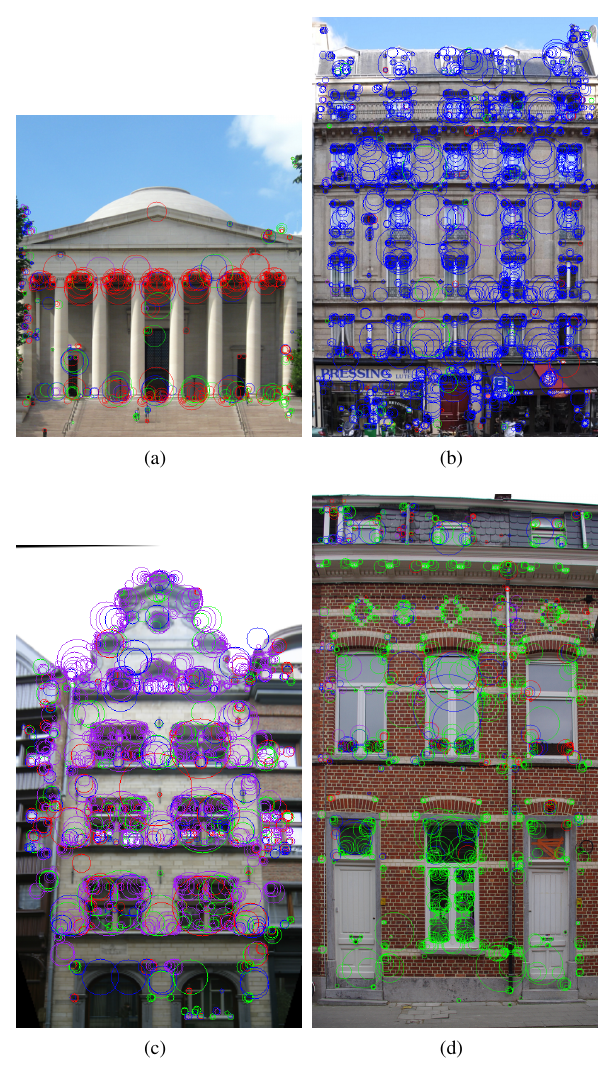
Figure 4: Style detection: a) Neoclassical style (features in red), b) Haussmannian style (features in blue), c) Renaissance style (features in purple) and d) Unknown style (features in